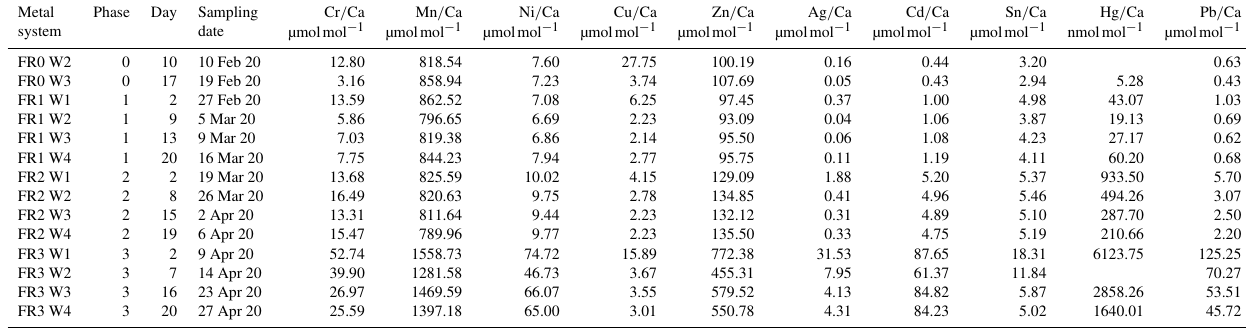
Table A1. TE / Ca Seawater values from single weeks during the culturing period of the metal system. Measurements were carried out with ICP-MS. These values are the basis for the calculations of the mean TE / Ca values in Table 3 and for Fig. B1.